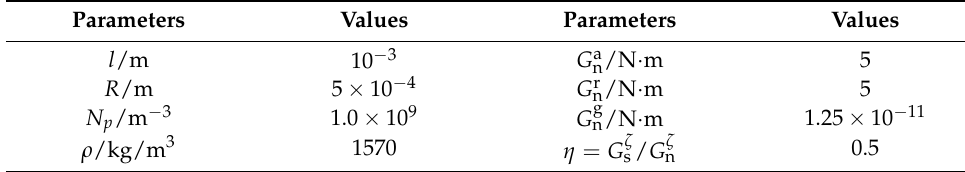
Figure 3. Dispersion curves of particle rotation waves under different a . Table 1. Values of model